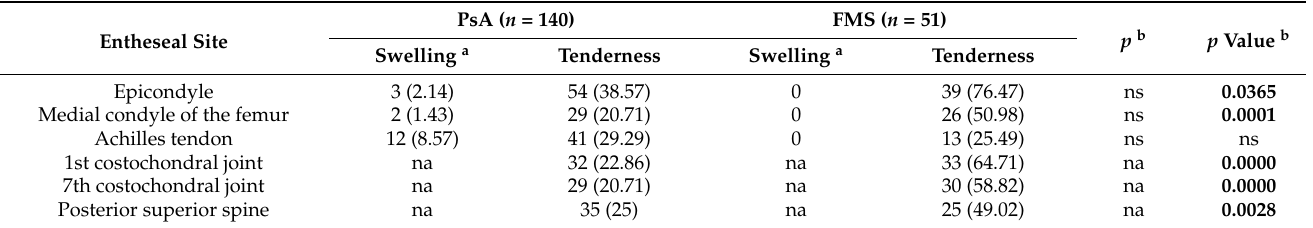
Table 2. Frequency of signs of enthesitis in all of the examined entheseal sites in patients with PsA and those with